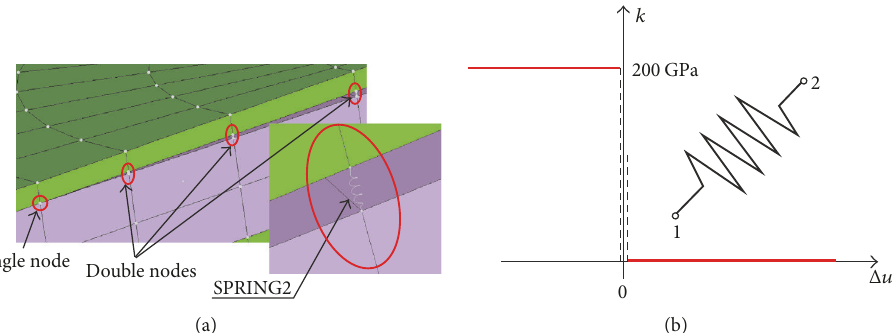
Figure 4: A detailed view of the linear model sandwich plate with debonding [56]: (a) zoomed debonded zone and (b) constitutive behaviour of the spring element.